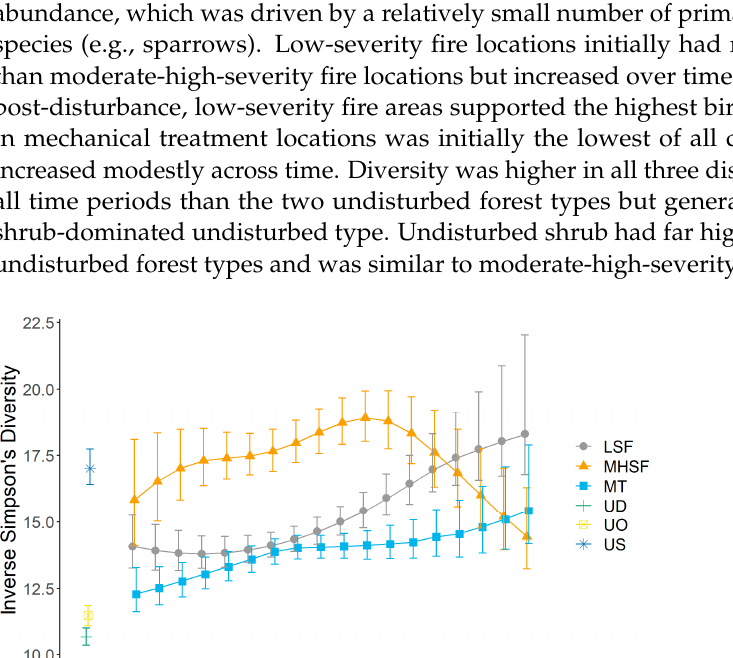
Figure 4. Inverse Simpson’s diversity calculated from modeled species abundance estimates pro- jected over time. Modeled abundance estimates were generated for each species within each dis- turbance type projected from characteristic vegetation values for tree cover, shrub cover, and snags (Figure A1), while holding all other model parameters constant. Error bars show the diver- sity of 5% and 95% CIs for species’ abundance estimates. MHSF = moderate-high-severity fire; LSF = low-severity fire; MT = mechanical treatment; UO = undisturbed open forest; US = undisturbed shrub; UD = undisturbed dense forest.